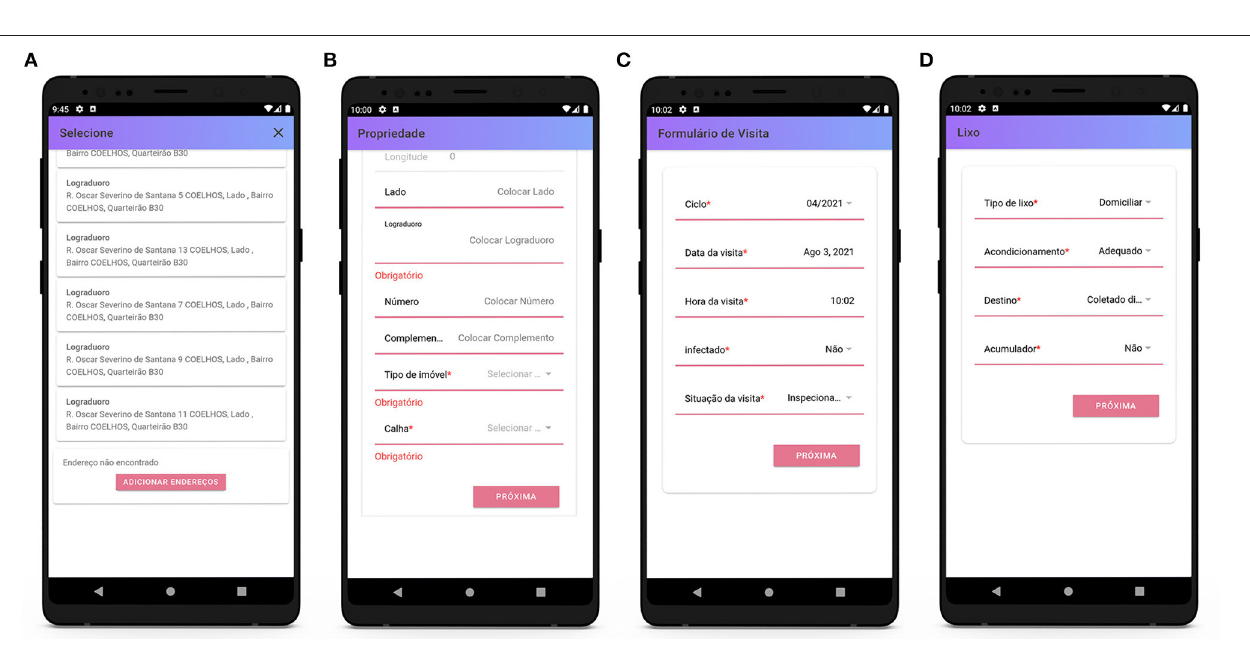
FIGURE 7 | Surveillance agents’ mobile application: descriptive and logistical sections of the form. (A) List of properties, (B) add new property, (C) visit form, and (D) waste form.